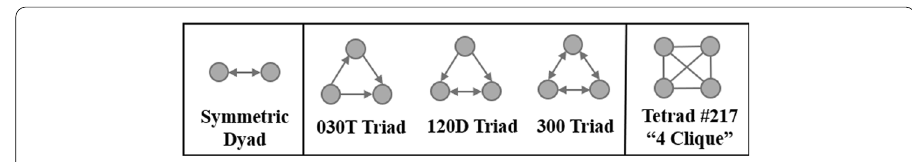
Fig. 1 Overrepresented directed dyads, directed triads, and symmetric tetrads